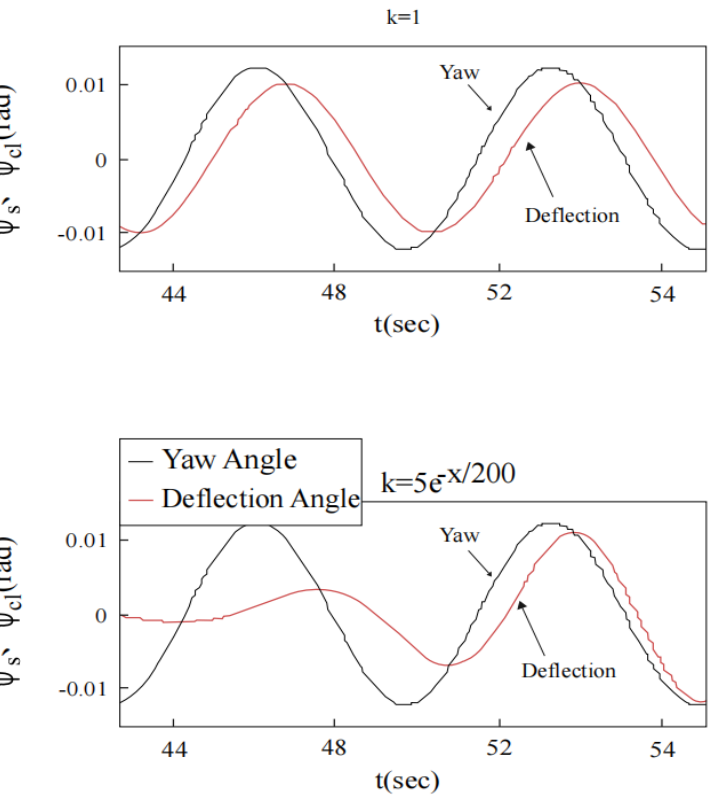
Figure 34. Tracking response curves of measurement axis under integral tracking strategies with different k values.